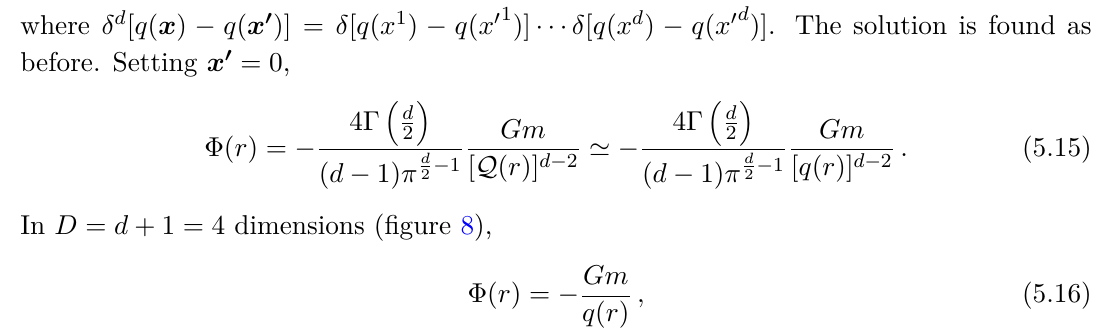
, solid thin curve) and for the exact ∗ = 1 ∗